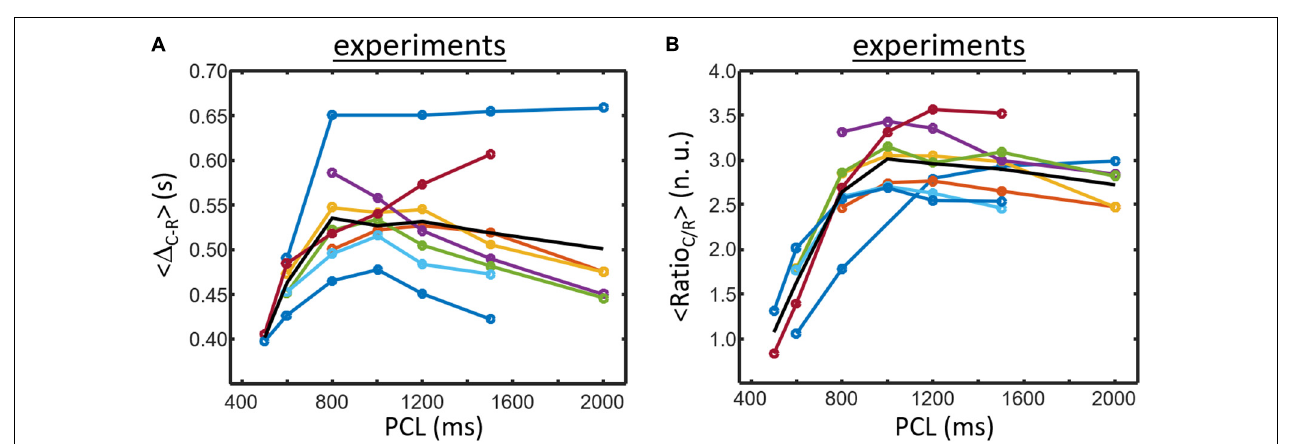
FIGURE 5 | Experimental data obtained for 8 samples electrically paced at different PCL. Each colored line corresponds to a sample results except for the black line that represent the mean of the 8 culture samples. (A) (cid:49) R - C is generally increasing for small PCL. The average curve (black line) exhibits a biphasic morphology which initially increases followed by a small decrease for large PCL (5/8 samples have similar morphology). (B) Ratio C / R usually starts low and is increasing when PCL increases. A biphasic pattern is also found for Ratio C / R (7/8 samples) and is also seen for the average curve (black line).